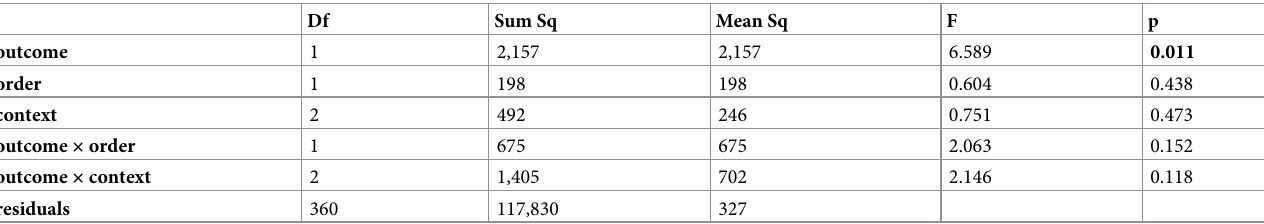
Table 10. Analysis of variance using change score as the criterion.